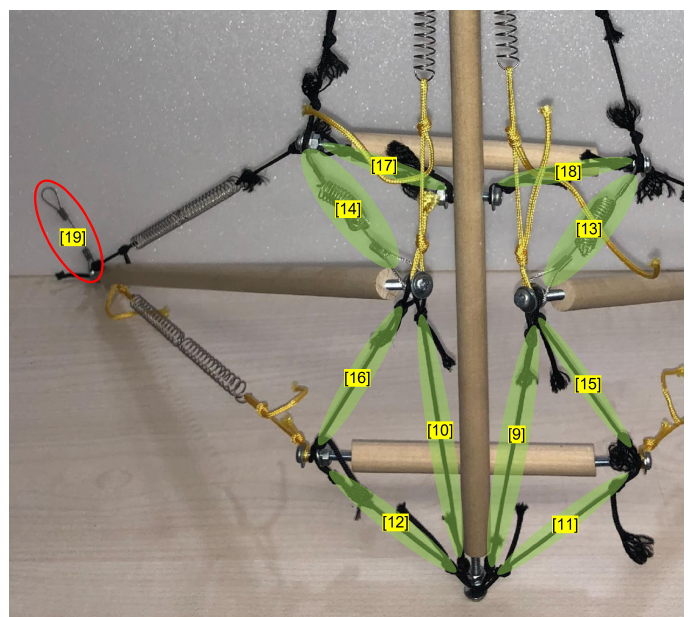
Figure 8. The numbers of tensile materials around the elbow. The tensile member leading from the elbow end of the upper arm to the elbow end of the right lower arm is No. 9; the tensile member leading to the elbow end of the left lower arm is No. 10; the tensile member leading to the right side of the outer elbow compression member is No. 11; the tensile member leading to the left side of the outer elbow compression member is No. 12; the tensile member leading from the right side of the inner compression member to the right lower arm is No. 13; and the tensile member leading from the left side of the inner compression member to the left lower arm is No. 14; the tensile member leading from the right side of the outer compression member to the right lower arm is No. 15; the tensile member leading from the left side of the outer compression member to the left lower arm